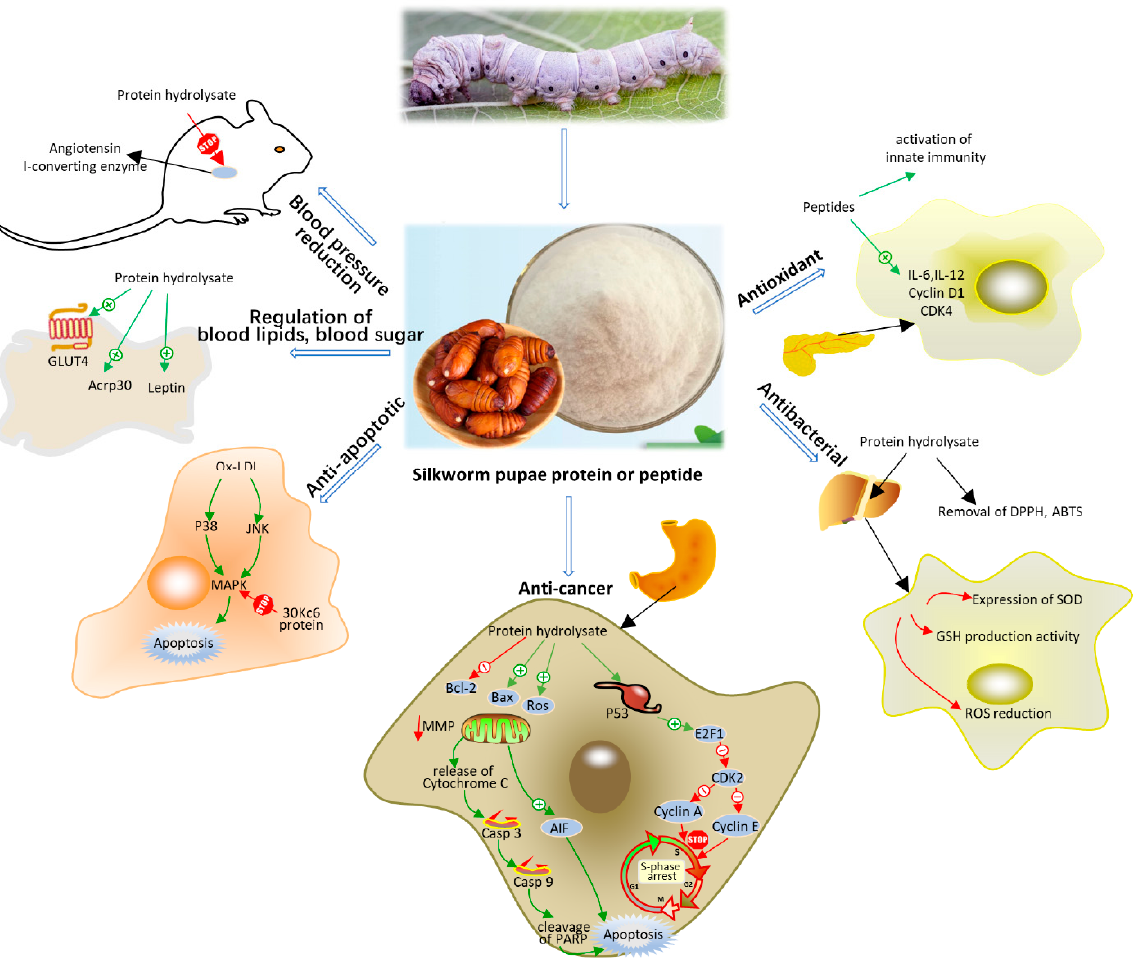
Figure 2. Function and physiological mechanisms of silkworm pupae proteins.